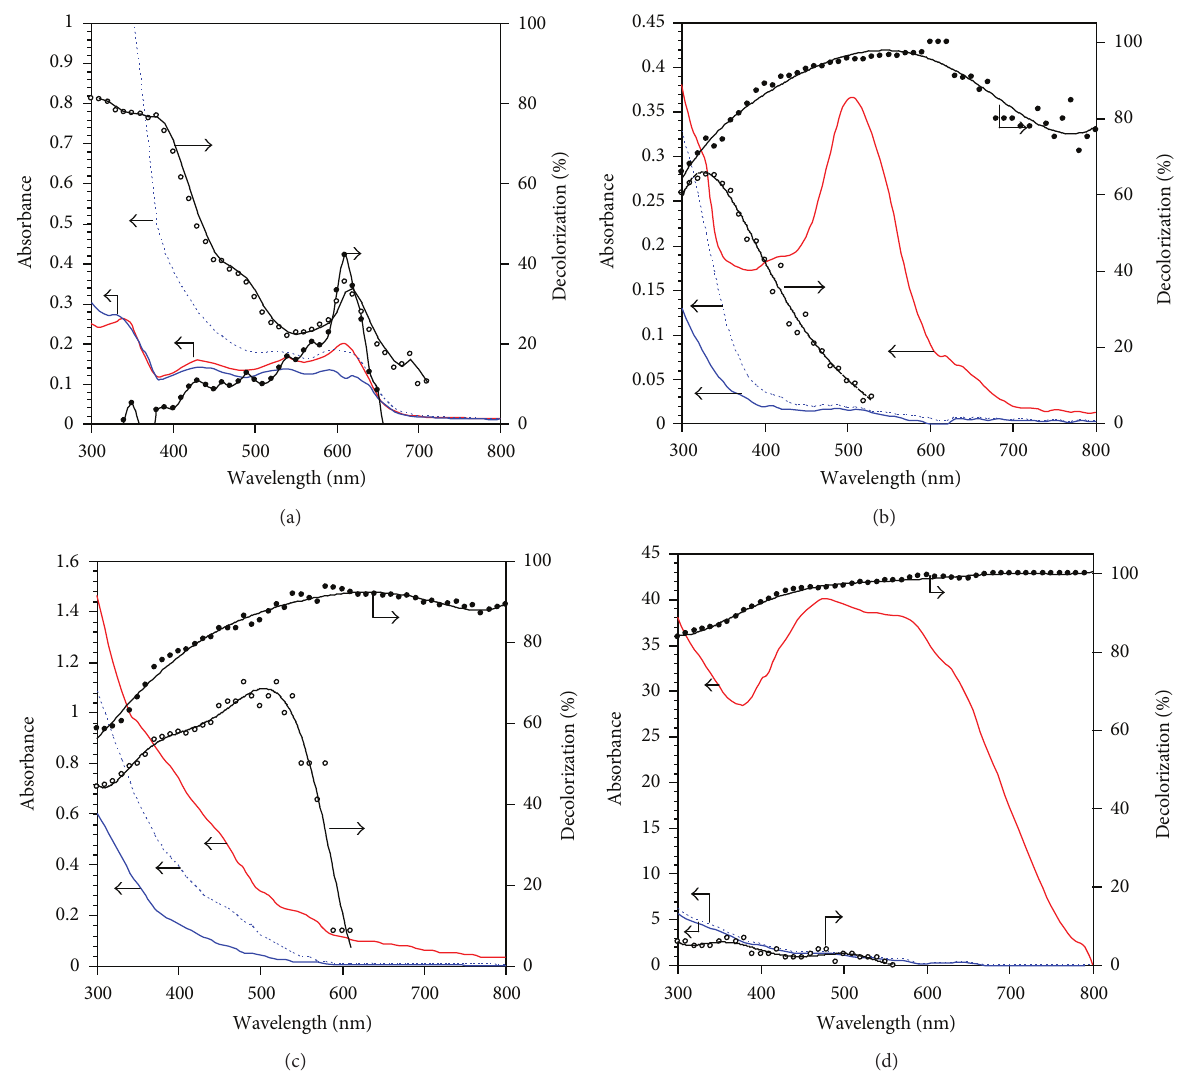
Figure 3: Absorption and decolorization spectra of WPac (a), WLeat (b), WFlax (c), and WCot (d). Solid line (red): initial spectrum of effluent, 𝐴 𝑜 ; dotted line (blue): effluent with TiO 2 and FeCl 3 but without UV-a irradiation, 𝐴 𝑌 ; solid line (blue): effluent with TiO 2 , FeCl 3 and after UV-a irradiation, 𝐴 𝑍 ; ( ∙ ) total decolorization of effluent with TiO 2 (2.5g L −1 ) and FeCl 3 (1.0 mmol L −1 ) and after UV-a irradiation; ( ⃝ ) decolorization of effluent as a result of the photocatalytic process in the presence of TiO 2 (2.5 gL −1 ), FeCl 3 (1.0mmolL −1 ), and after UV-a